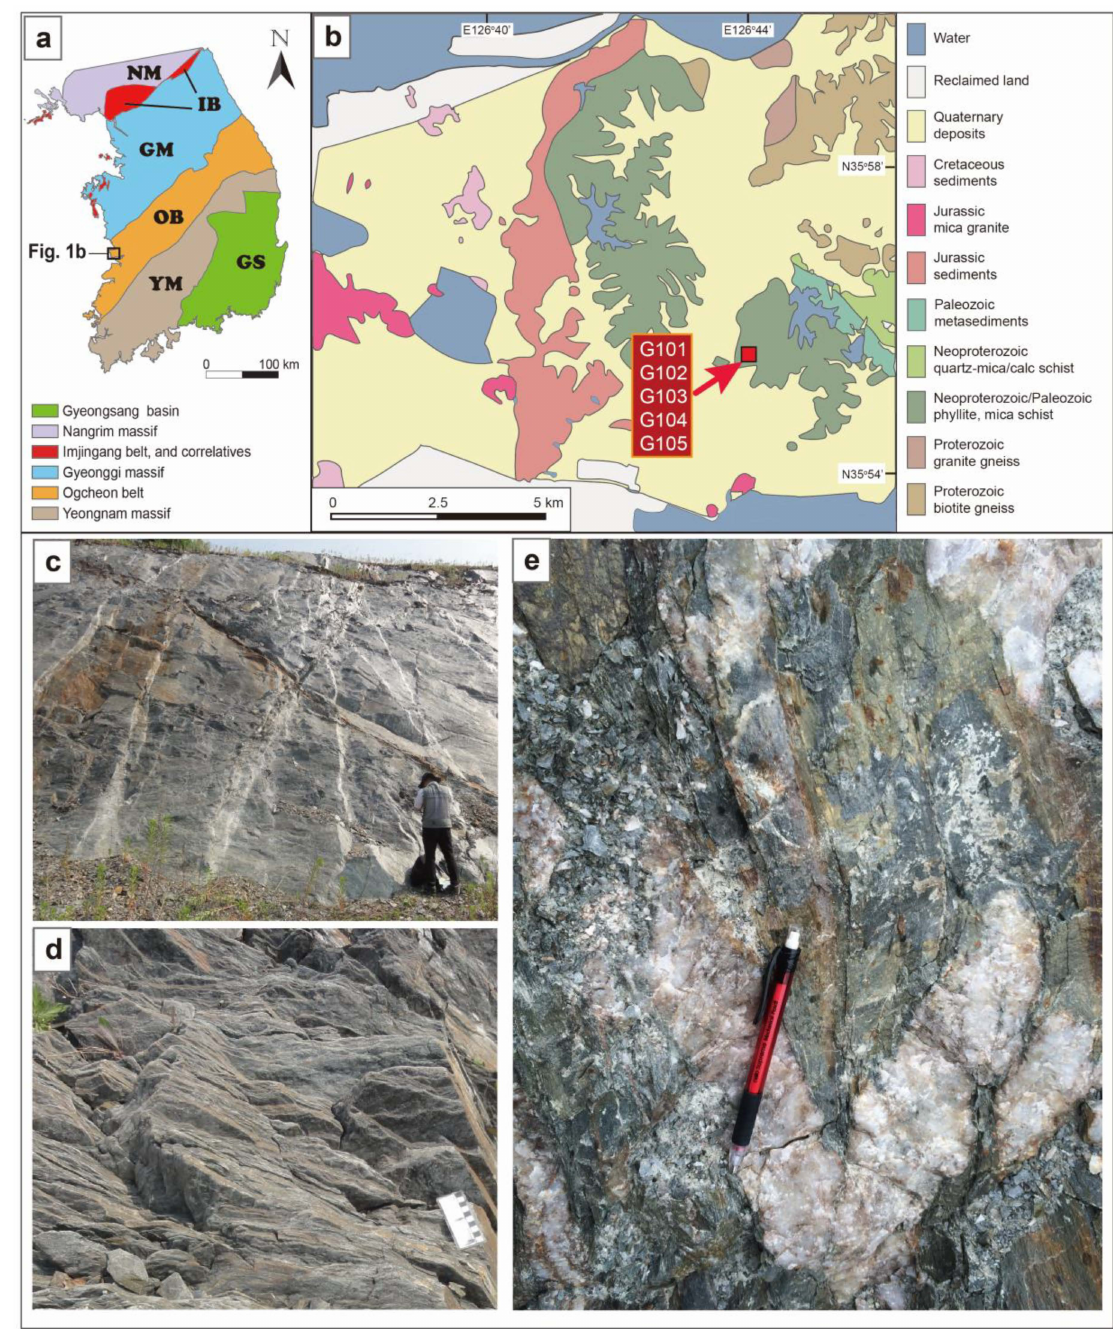
Figure 1. ( a ) Simplified tectonic sketch map showing the major tectonic units in the southern part of the Korean Peninsula. NM: Nangrim massif; GM: Gyeonggi massif; YM: Yeongnam massif; IB: Imjingang belt and correlatives; OB: Ogcheon belt; GS: Gyeongsang basin (reprinted with permission from ref. [81]. Copyright 2020 Elsevier). ( b ) Geological map of the Gunsan area and sample location (reprinted with permission from ref. [82] and ref. [83]. Copyright 2020 Korea Institute of Geoscience and Mineral Resources). ( c ) Field photograph showing phyllite outcrop of the Geumseongri Formation. ( d ) Close-up view of a strongly deformed phyllite showing well-developed foliation. ( e ) Folded and boudinaged quartz veins discordantly cutting phyllite